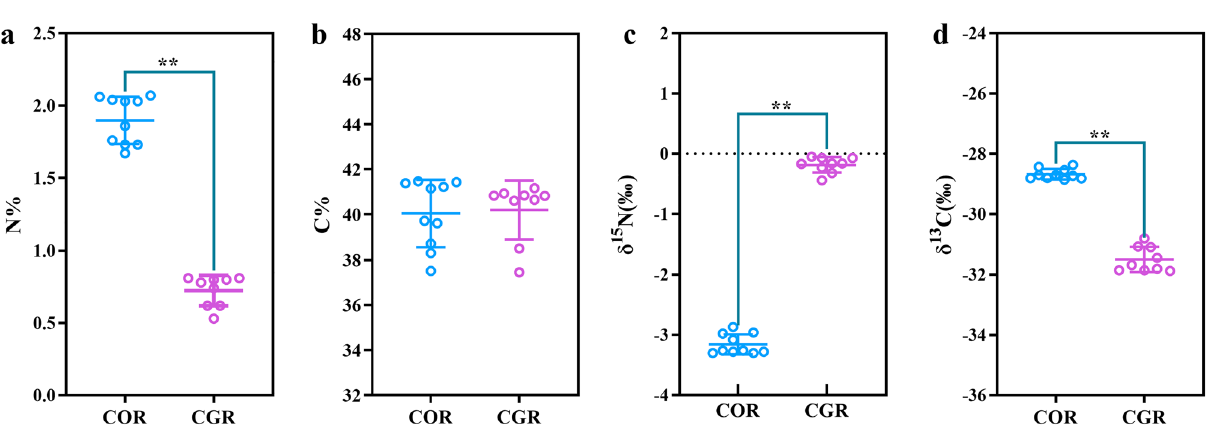
Figure 3. The relative content of N element (N%, a ), C element (C%, b ) and nitrogen isotope ratio (δ 15 N, c ) and carbon isotope ratio (δ 13 C, d ). Data were expressed as the mean ± SD. (** P <